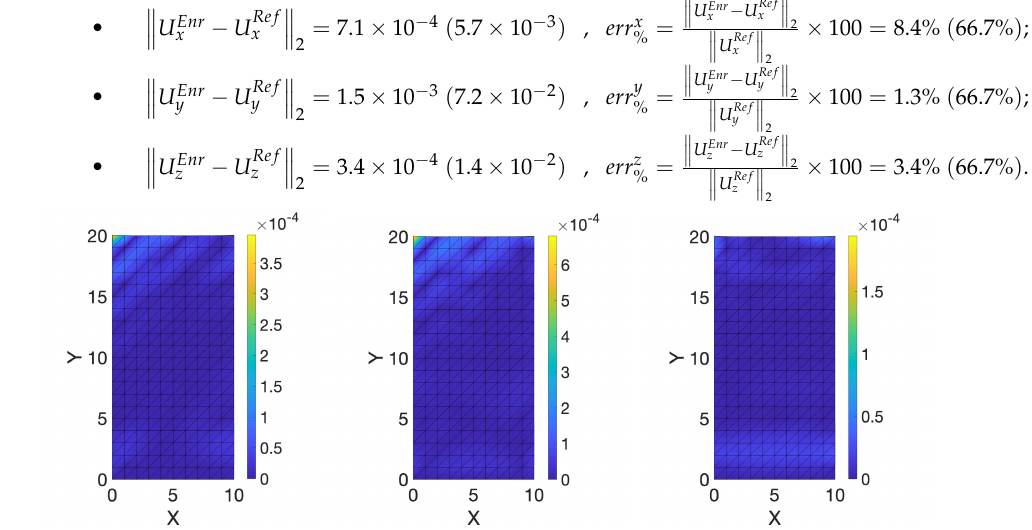
Figure 20. Top view of the difference in absolute value between the corrected and the reference displacement field, for x ( left ), y ( middle ) and z ( right ) components.